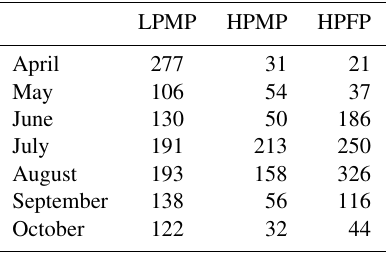
Table 2. Monthly occurrences of precipitation systems according to the precipitation types from April to October in the period of 2013–